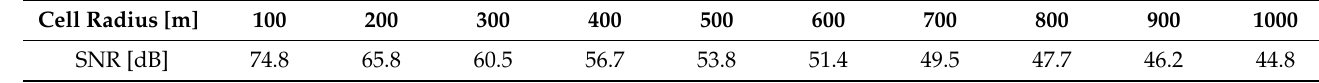
Table 1. The average received SNR of the farthest user.